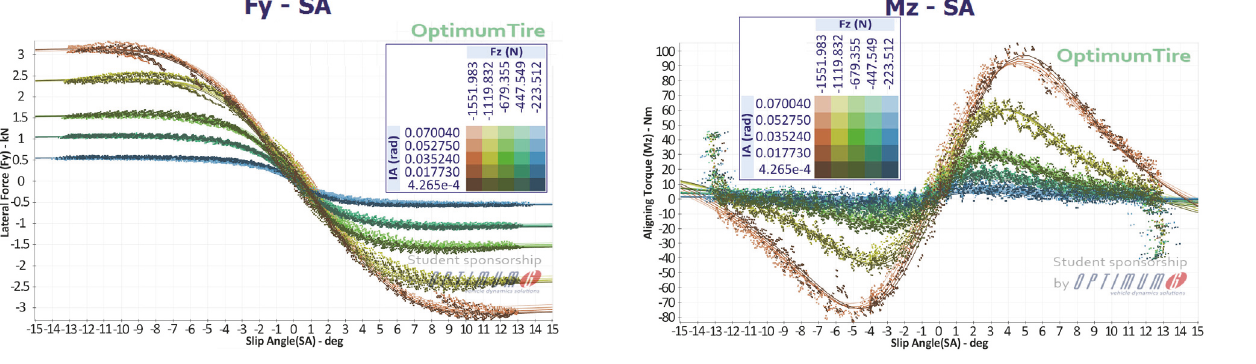
Figure 4: Lateral force at pure side slip. Figure 5: Aligning moment at pure side slip.